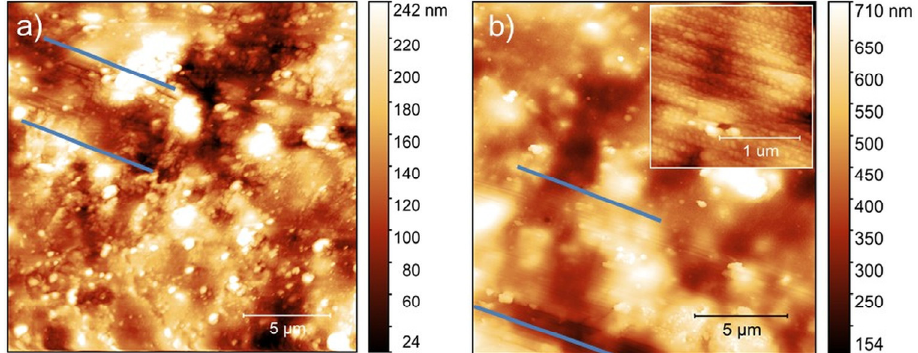
Figure 5. 20 × 20 µm 2 AFM images of the surface before ( a ) and after ( b ) Ag deposition. Blue lines in Figure 5a indicate a fibre-like region; the latter regions resulted conformally coated by the silver